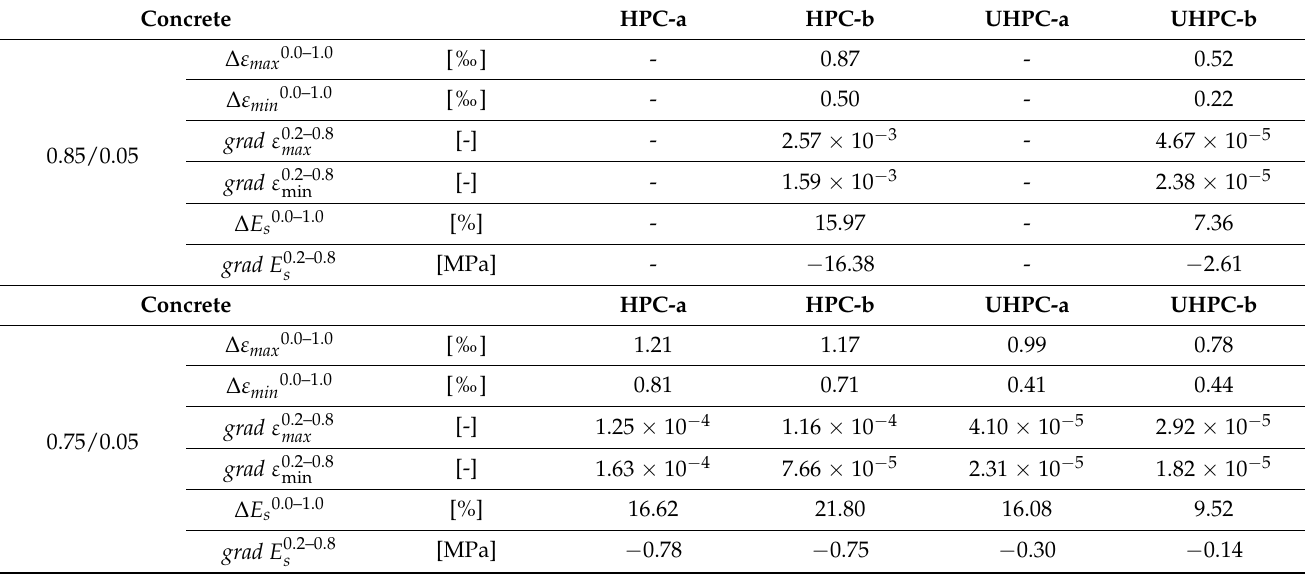
Table A4. Mean values of parameters of fatigue damage indicators